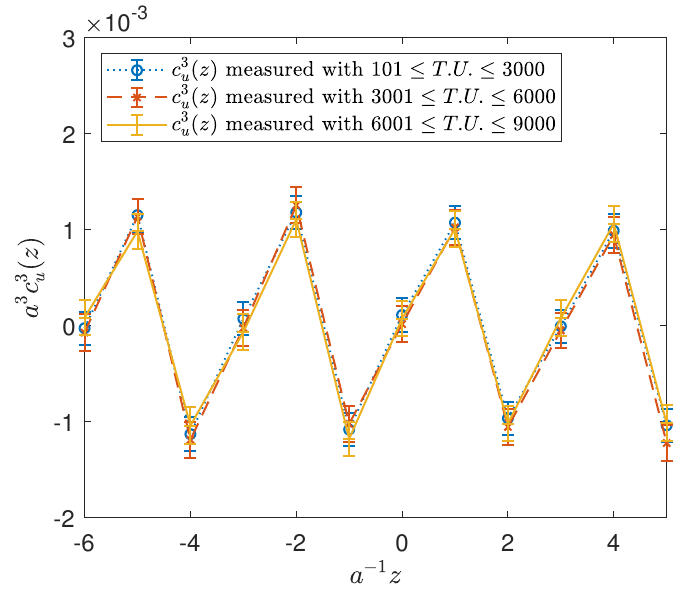
Figure 17 . The oscillations of c 3